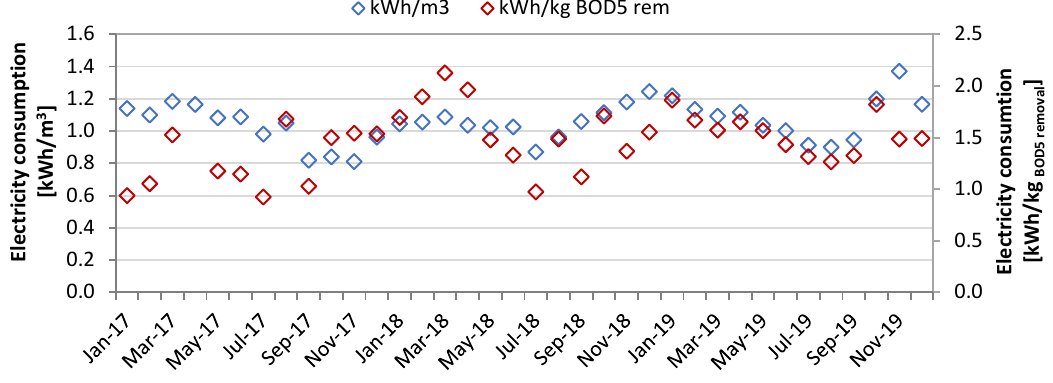
Figure 12. Energy intensity of the WWTP in Iława .